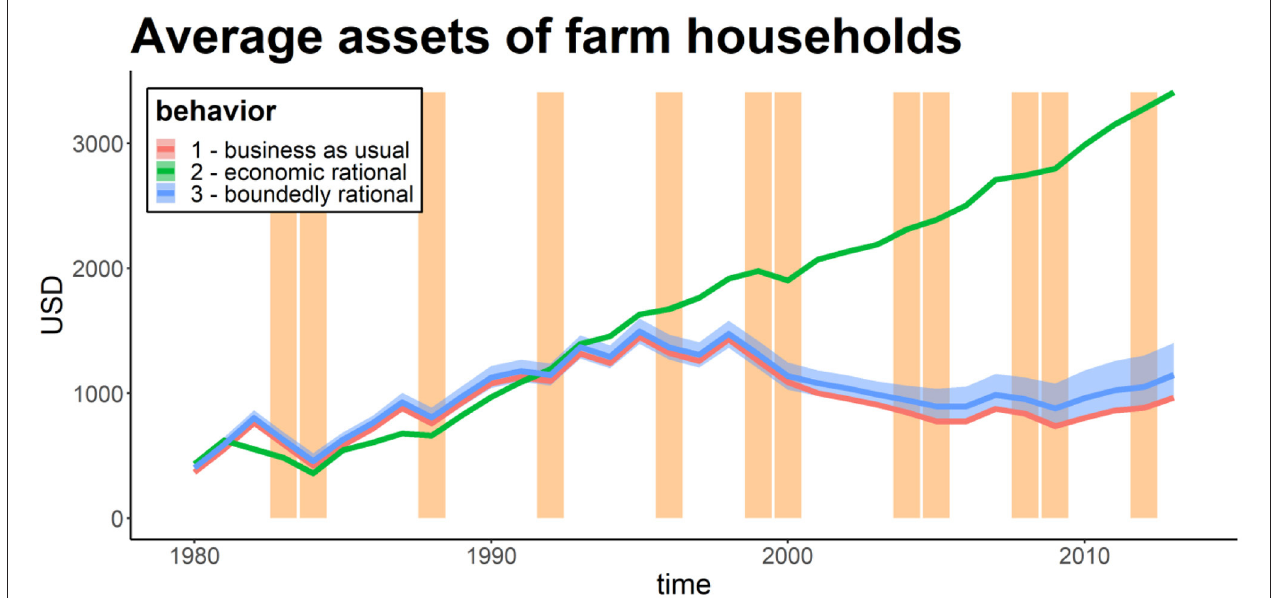
FIGURE 5 | Households’ financial assets (in US$/year) over time. Visualized is the median assets stock of all households modeled for three scenarios: no adaptation decisions (BAU), economic rational (EUT), and bounded rational (PMT) adaptive behavior. Drought years (SPEI value in crop season < − 1) are visualized as vertical orange bars. The shaded blue area shows the variance among 48 bounded rational model runs, a result of the variety in weights of the PMT